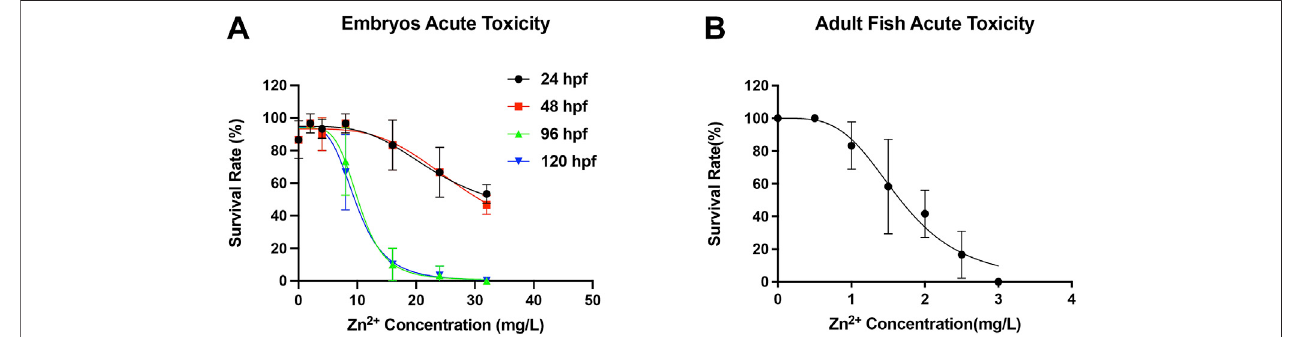
FIGURE 4 | Survival rate in (A) embryos (N = 10) and (B) adult fi sh (N =